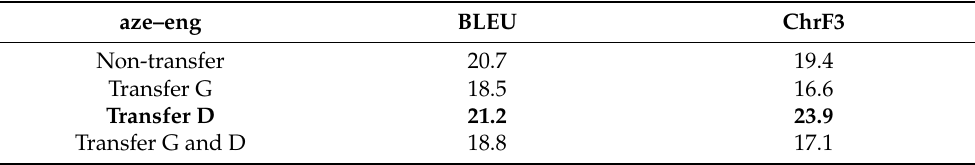
Table 5. Transfer learning of LAC from tur-eng to